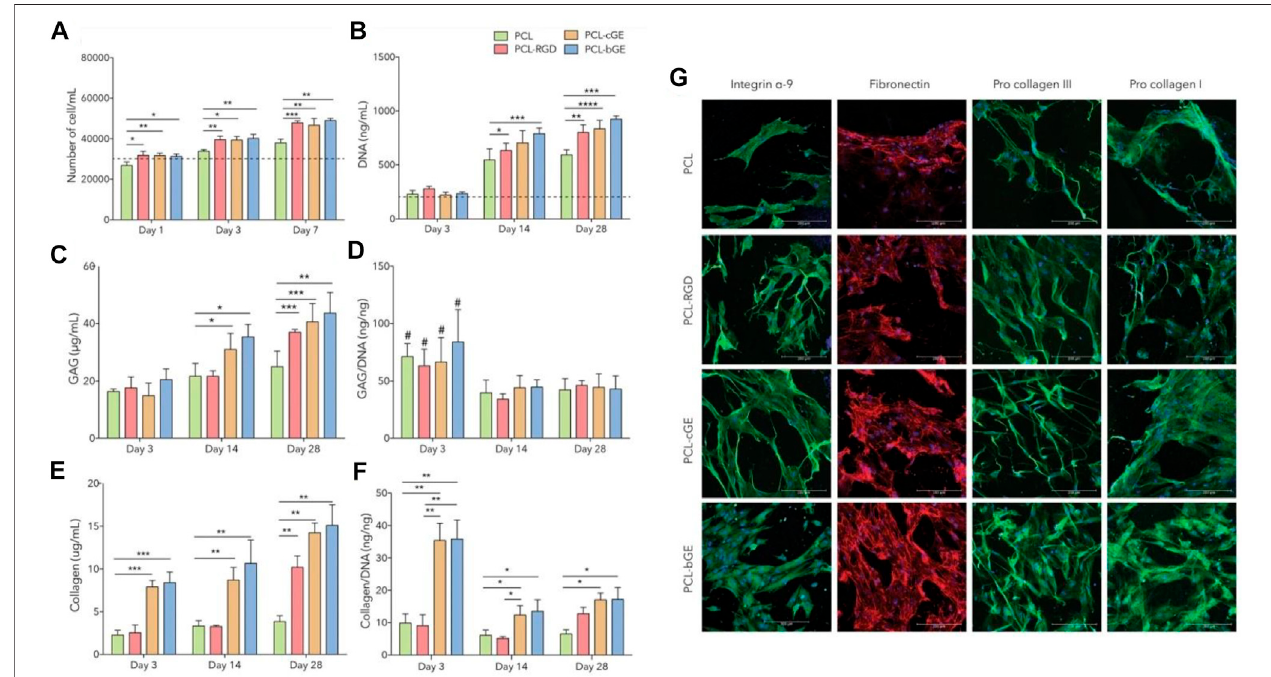
FIGURE 5 | Gel/PCL nano fi bers provoke the generation of ECM components by hSKPs. (A) hSKPs cell proliferation, (B) DNA content of the cells rises over the course of co-culture of the cells and the blended nano fi bers implying the impact of Gel and RGD on the cell proliferation. PCL-cGE and PCL-bGE represent Gel coated and Gel blended PCL nano fi bers, respectively. In (a&b), the dotted line is representative of primary cell number and DNA content, respectively, (C) The amount of GAG secretedin adjacenttodifferentclasses ofthe nano fi bers, (D) GAG/DNA ratioof thenano fi bers (#, i.e., p < 0.05 implies astatistically signi fi cantdifference between day 3 and day 14/day 28, (E) The total amount of secreted collagen, (F) Collagen/DNA ratio (****, ***, **, and * represent p (cid:1) 0.0001, p < 0.001, p < 0.01 and p < 0.05, respectively). (G) Immuno fl uorescent images show the cellular activities of hSKPs on the Gel/PCL nano fi bers, represented by expression of integrin α -9 (green), fi bronectin (red), and procollagen I & III (green). Reproduced with permission. (Anjum et al., 2017), Copyright 2017, Nature.